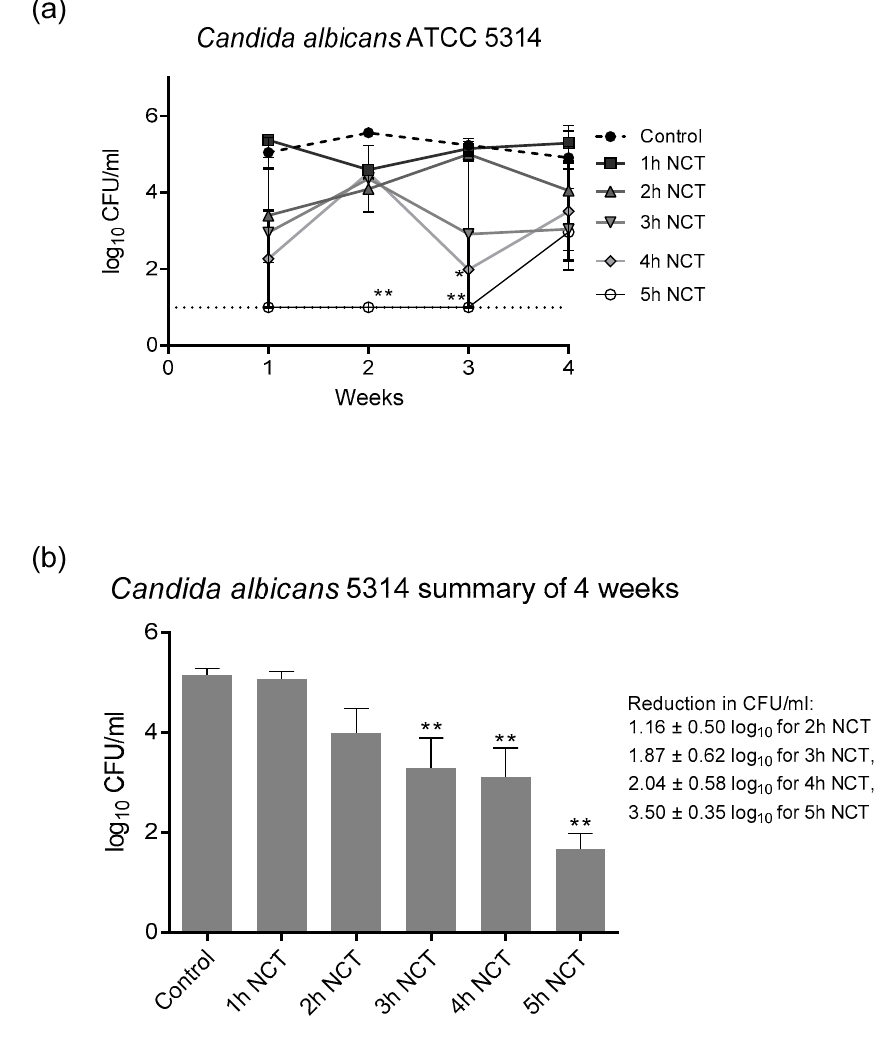
Figure 5. ( a ) Fungicidal activity of 1% NCT at pH 7 and 37 °C against biofilms of C. albicans ATCC 5314 grown for 4 weeks. Weekly evaluation by quantitative killing assays. Mean values ± SEM, n = 3 ( n = 2 for week 2); * p < 0.05 versus control; ** p < 0.01 versus control. ( b ) Summary of all values of NCT and controls over the 4 weeks of Figure 5a. Mean values ± SEM, n = 9–12; ** p < 0.01 versus control; n.s.: not significant.